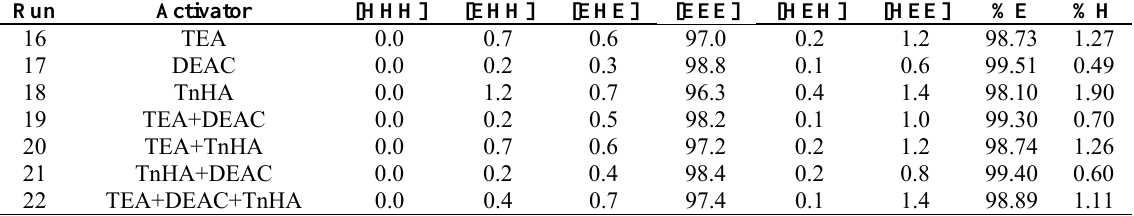
Table 4. Triad distribution based on 13 C-NMR for EH copolymer obtained from different activators.